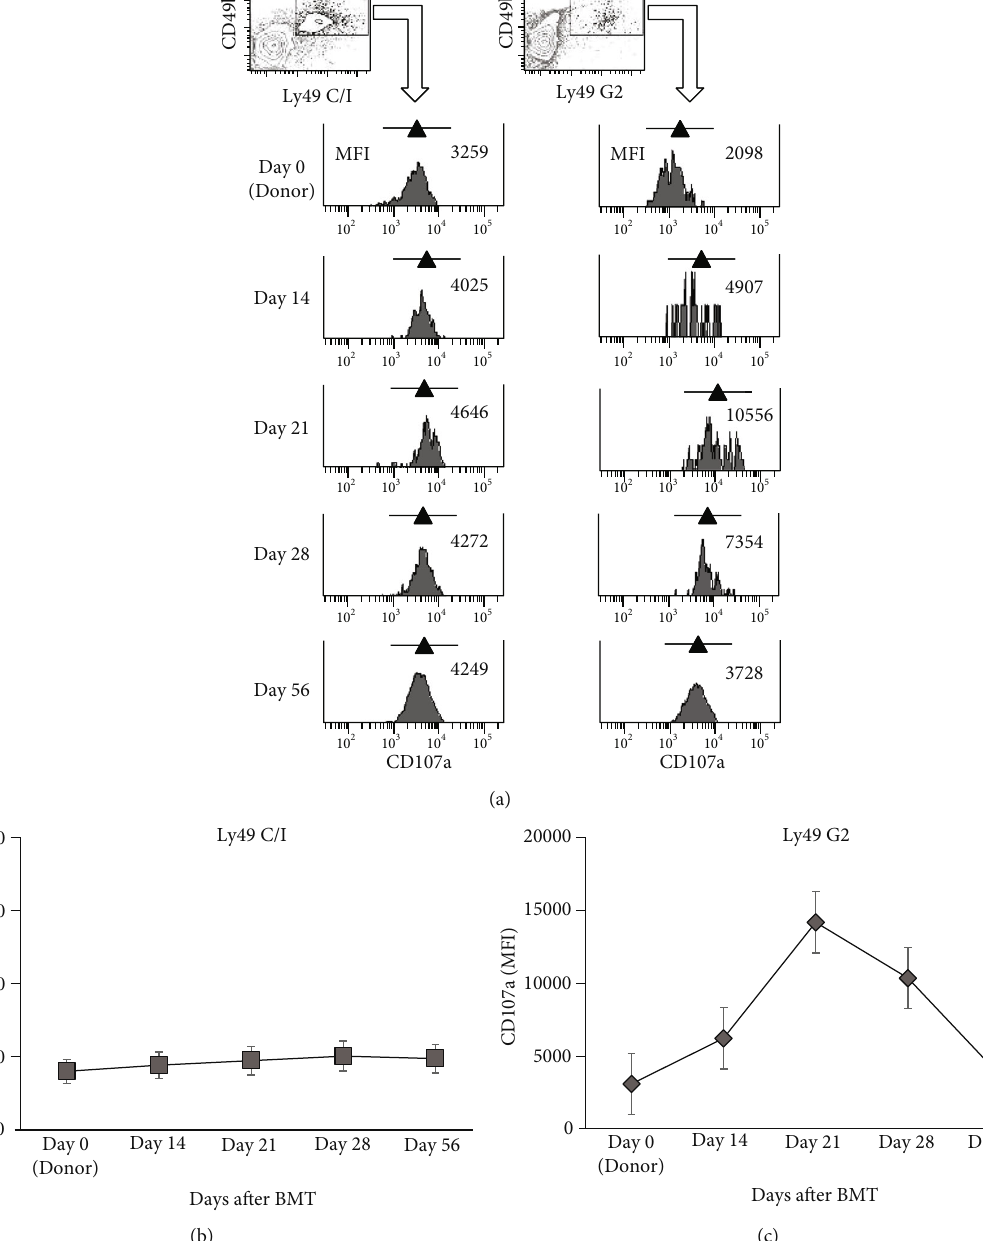
Figure 2: Changes in the function of NK cells after BMT. The expression of CD107a, as a functional marker for the identi fi cation of NK cell activity, was detected by fl ow cytometry in each Ly49C/I + and Ly49G2 + NK cells of recipient mice before BMT (day 0: donor, n = 12 ) and on days 14 ( n = 7 ), 21 ( n = 7 ), 28 ( n = 7 ) and 56 ( n = 5 ) after BMT. The mean fl uorescence intensity (MFI) is shown in number and triangle symbol in the upper right corner of each plot in the representative data (a). The activity of Ly49C/I + NK cells (b) and Ly49G2 + NK cells (c) of recipient mice was determined as the MFI plus or minus standard deviation values of three independent